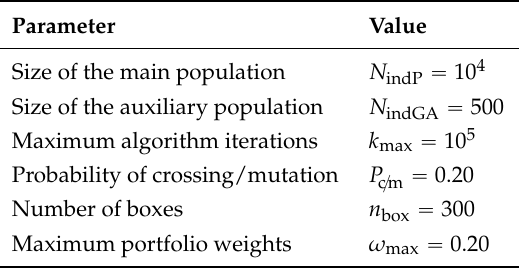
Table 1. Parameter setting of the